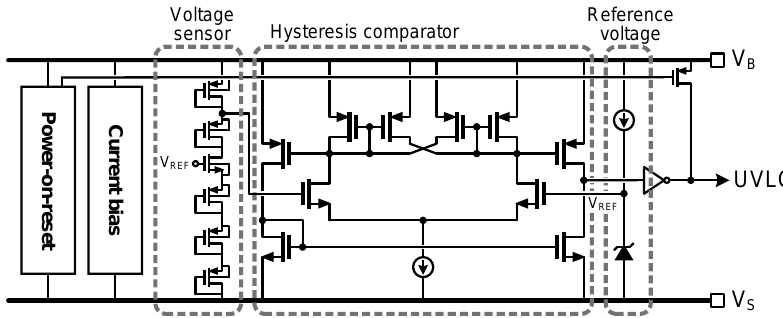
Figure 4. Proposed high-side under-voltage lockout circuit.